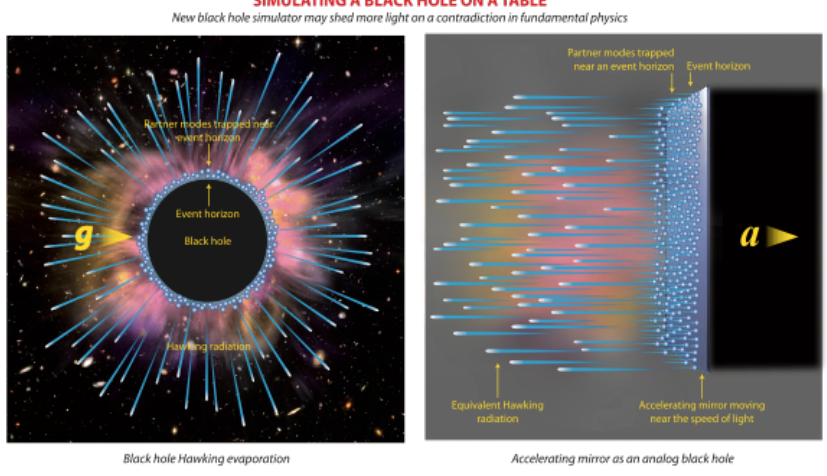
Figure 1. The analogy between the Hawking radiation from a true BH ( left ) and that from an accelerating mirror ( right ). One may intuitively appreciate the analogy based on Einstein’s Equiva- lence